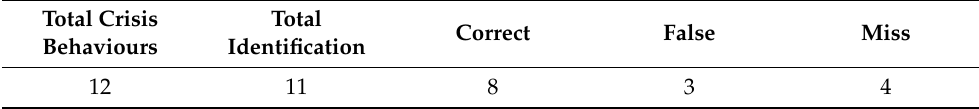
Table 10. Evaluation of crisis behaviour identification on test